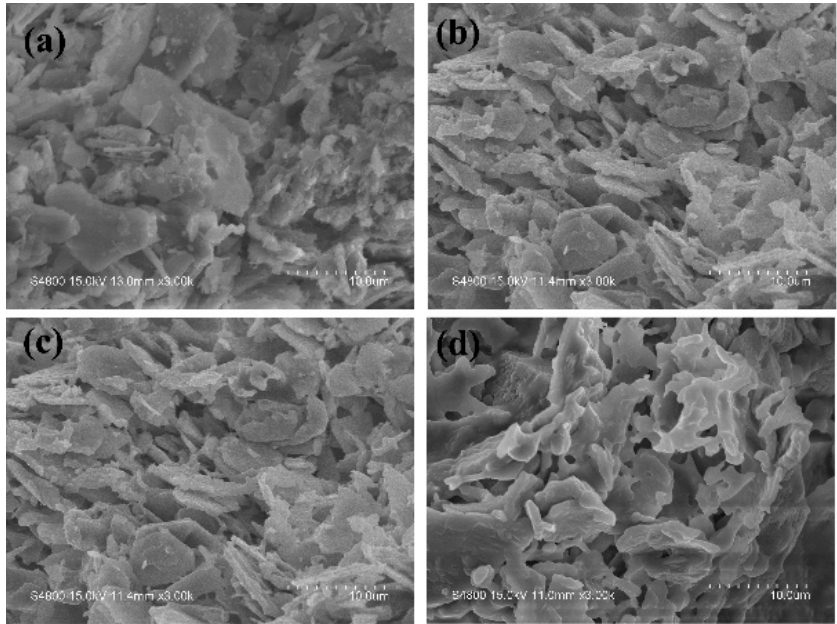
Figure 16. FESEM images of the sintered specimens sintered at different temperatures: ( a ) 400 °C, ( b ) 600 °C, ( c ) 800 °C, ( d ) 1000 °C.